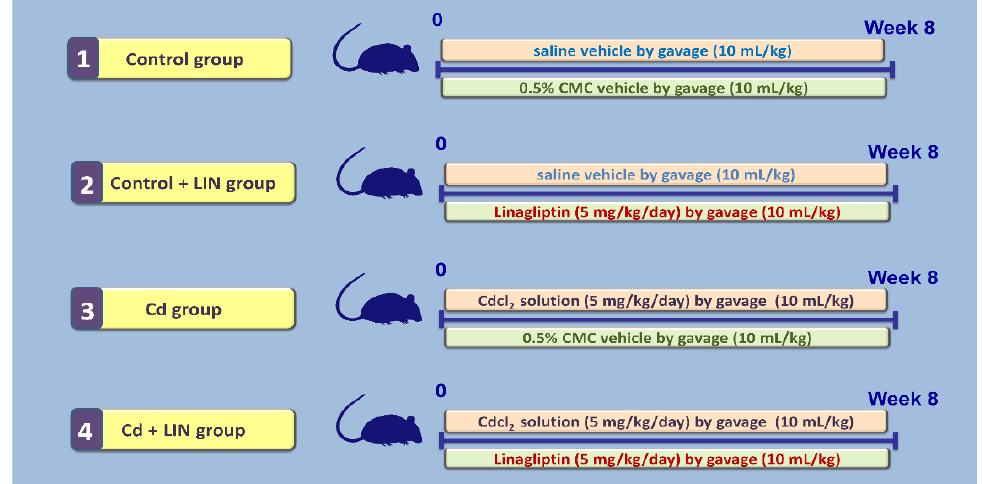
Figure 12. An outline of the current experimental protocol. LIN, linagliptin; Cd, cadmium chloride; CMC, 0.5% carboxymethyl cellulose.